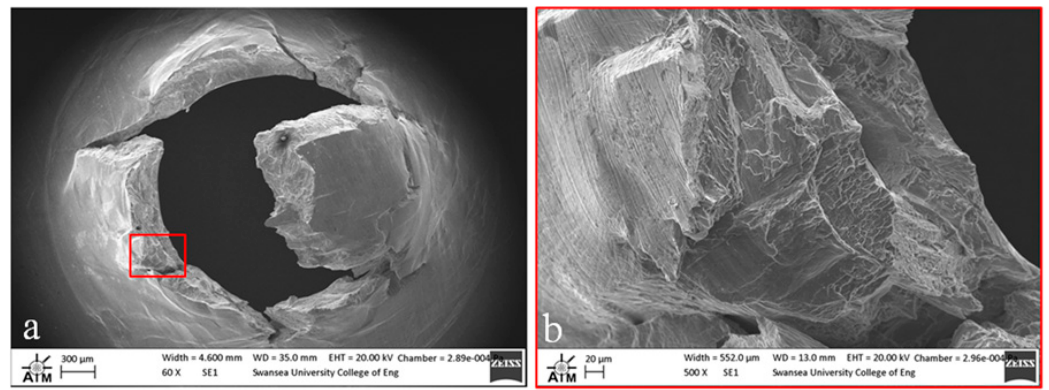
Figure 12. SEM images of fractured SP disc of the cast and HIP Ti-6Al-4V material showing ( a ) overall fracture surface and ( b ) typical rupture behaviour.